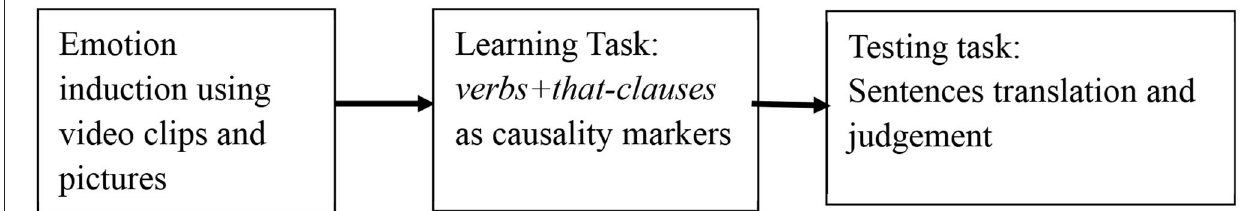
FIGURE 2 | Procedure of the study.